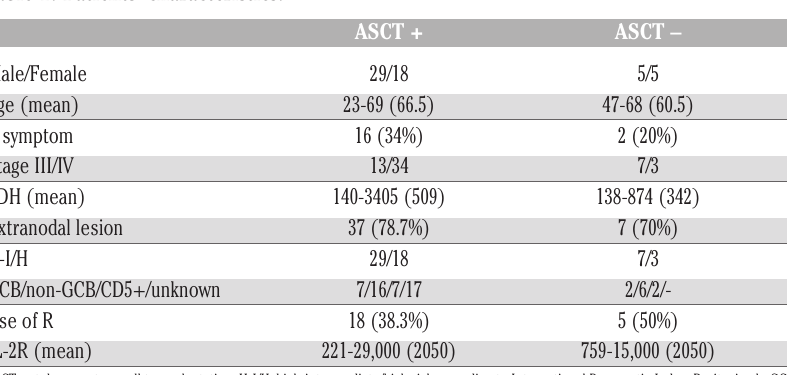
Table 1. Patients’ characteristics.